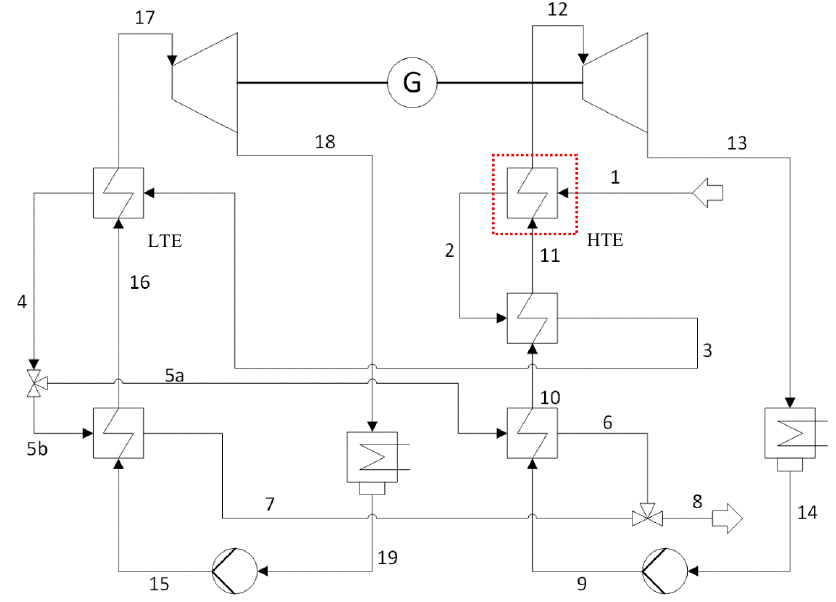
Figure 8. Dual-pressure ORC system in Sauerlach, Germany. High temperature evaporator (HTE) in red box.